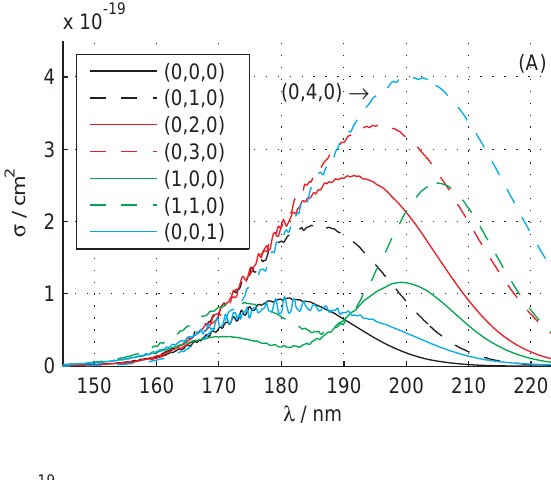
Table 2. Isotopic shift in vibrational energies in cm − 1 . Experimental gas phase values cited in Łapi´nski et al. (2001) are given in parenthesis. The shifts are defined as 1 18 E = E( 14 N 216 O ) − E( 14 N 218 O ) and 1 18 E isotopes.